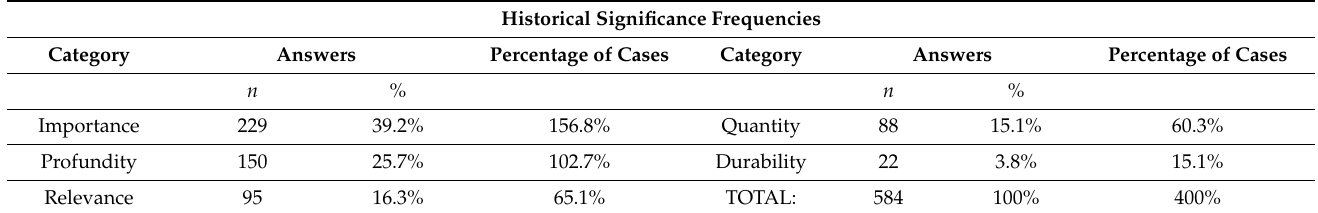
Table 4. Historical significance chosen by the students to justify their